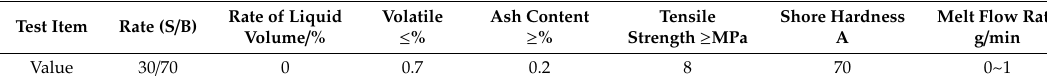
Figure1. Additives: ( a )GranularPolymerDurableadditive(GPDa); ( b )Styrene–Butadiene–Styrene(SBS). Table 7. Physical Properties of Styrene–Butadiene–Styrene (SBS).